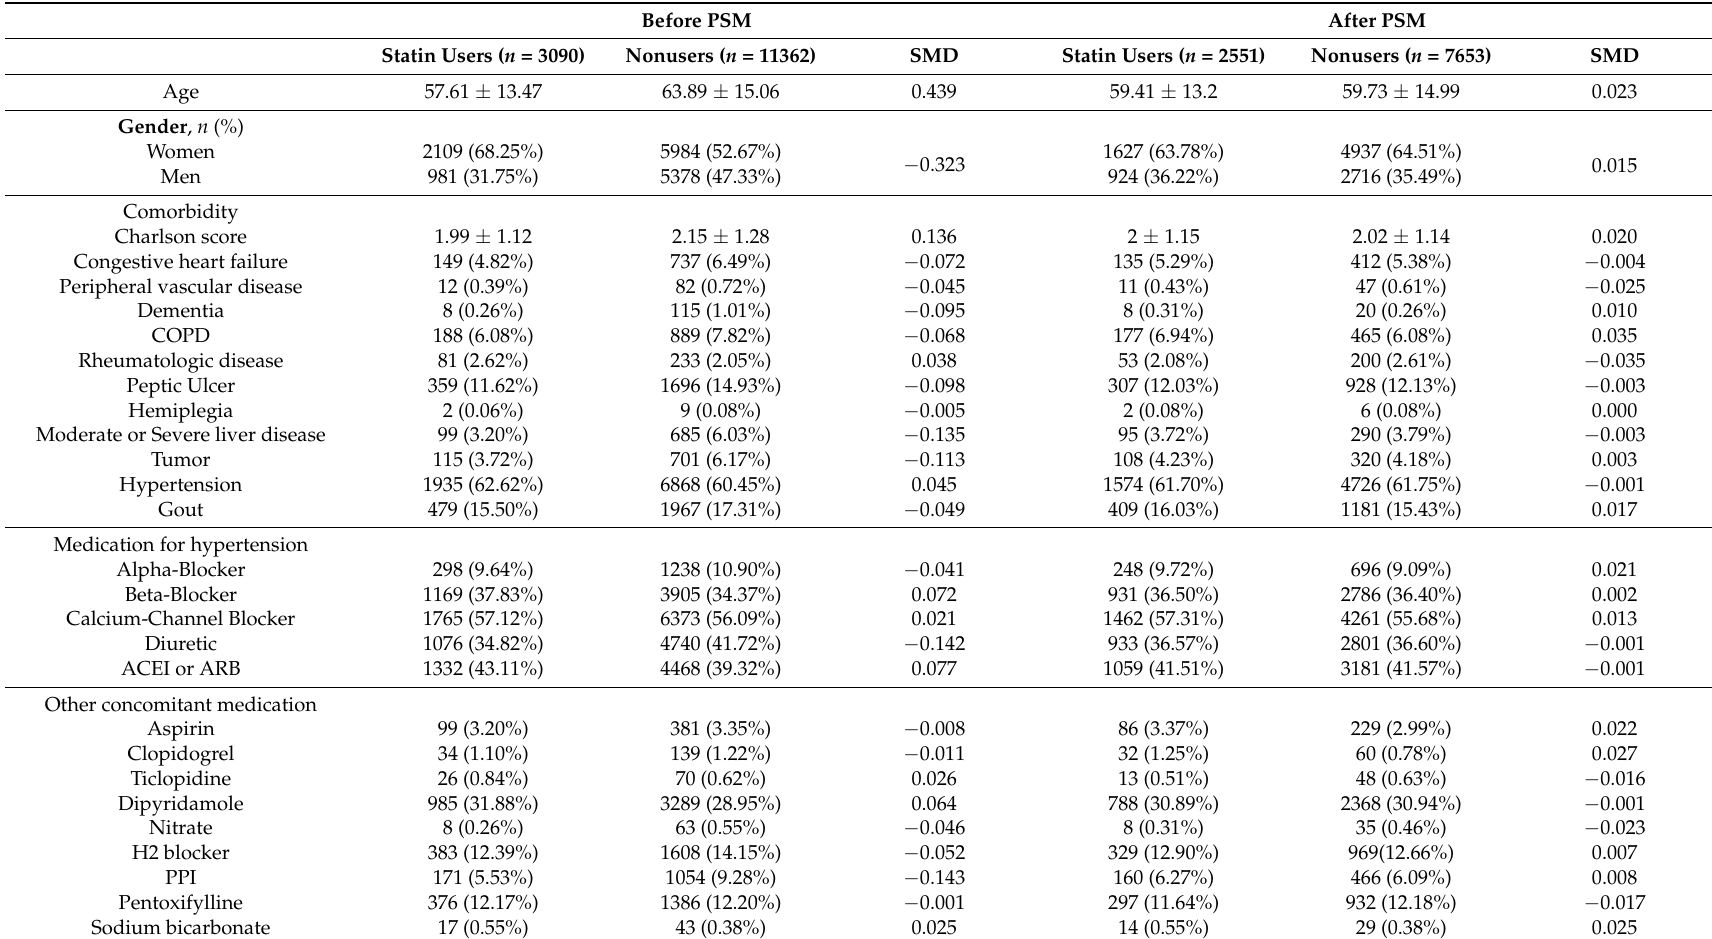
Table 1. Clinical characteristics of statin users and non-users before and after propensity score